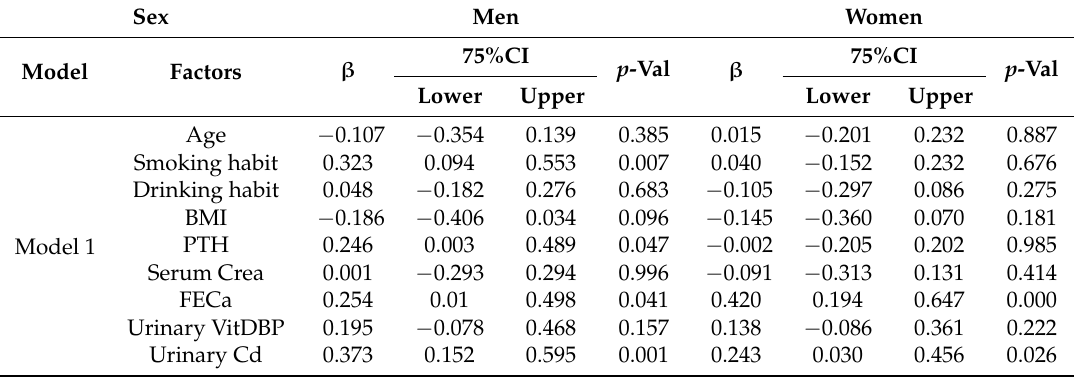
Table 3. Multiple regression analysis of urinary NTx with relevant factors including Cd exposure